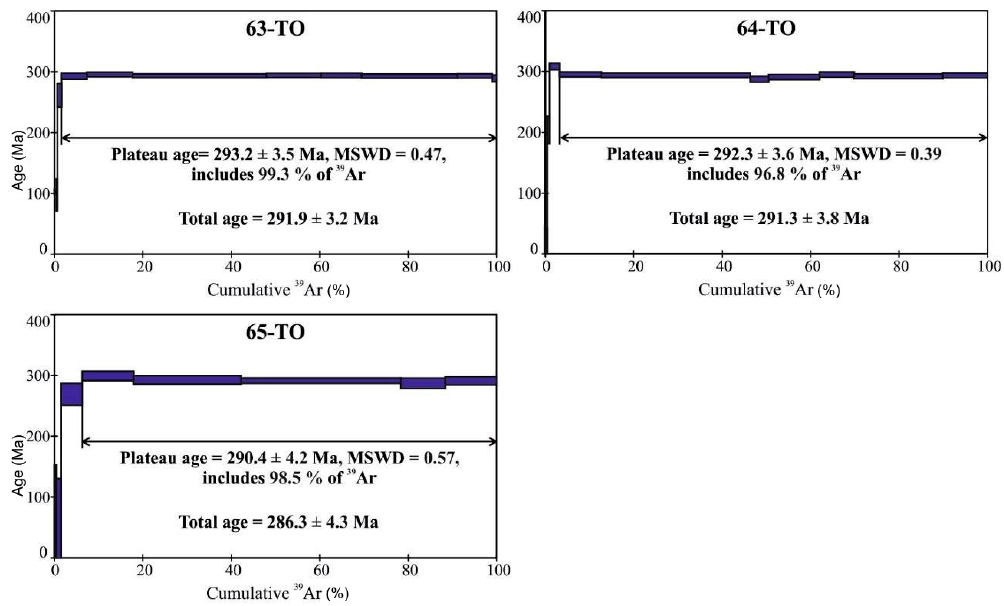
Figure 14. 40 Ar/ 39 Ar age spectra of muscovite from the Tochka pegmatite.